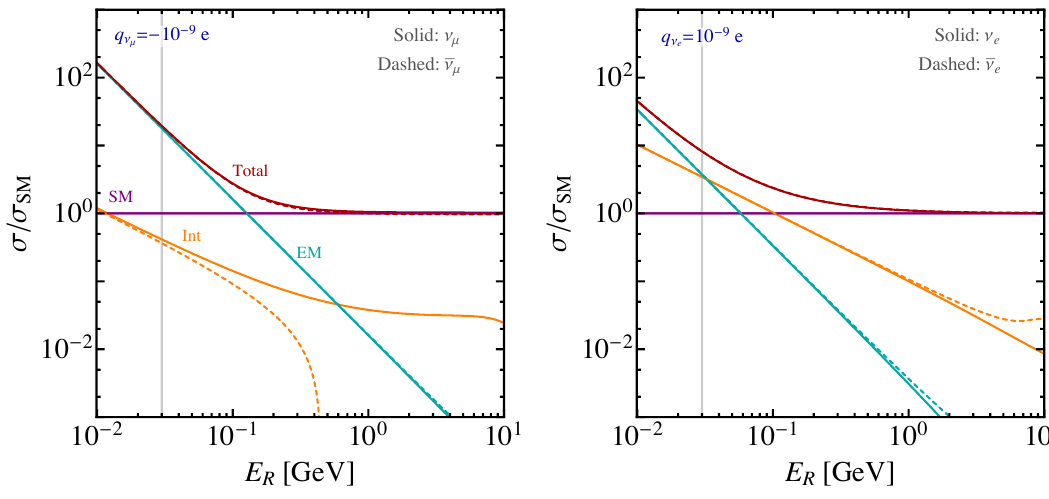
Figure 4 . The ratio of different terms of the milli-charge cross section over the SM cross section for the muon neutrinos (left panel) and electron neutrinos (right panel). We have shown the different contributions with the SM (purple), interference between the SM and the milli-charge contribution (Int, orange), the quadratic term with respect to the milli-charge (EM, blue) and the total cross section (red) curves. The solid (dashed) curves belong to (anti-)neutrinos. The vertical line is the 30 MeV threshold energy at DUNE and we have fixed the neutrino energy to 10